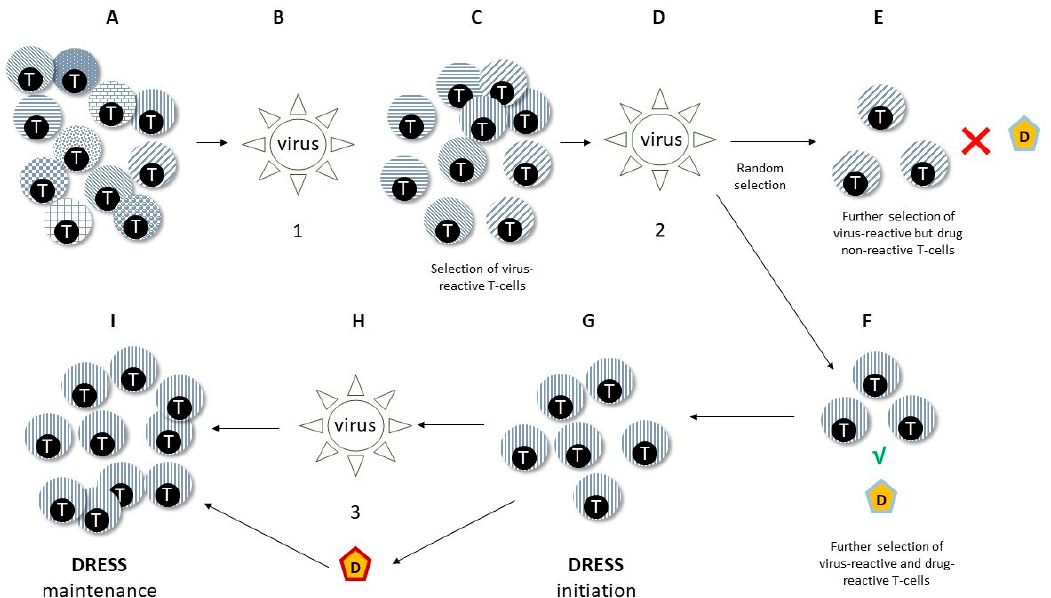
Figure 3. Potential mechanisms of heterologous immunity in DRESS. This figure depicts features of heterologous immunity with a potential pathogenic role in DRESS. Viral infections or reactivations (1–3) prompt selective pressure on a heterogeneous pool of T-cells ( A ). Therefore, after exposure to viruses ( B ), virus-reactive T-cells expand ( C ) and are readily available for eventual viral encounters or reactivations ( D ). Among virus-reactive T-cells, subpopulations harbouring T-cell receptors devoid of the ability to be activated by potential drug allergens might be selected ( E ), preventing the occurrence of hypersensitivity. In other cases ( F ), either occurring in distinct subjects or in the same subjects during distinct phases of life, virus–drug cross-reactive T-lymphocytes might be selected by viral stimulation. When challenged with culprit drugs, these cells might initiate hypersensitivity reactions, possibly including DRESS ( G ). Eventually, re-challenge with re-activating viruses ( H , top ) or chemically related drugs ( H , bottom ) might promote DRESS progression and/or persistence ( I ).